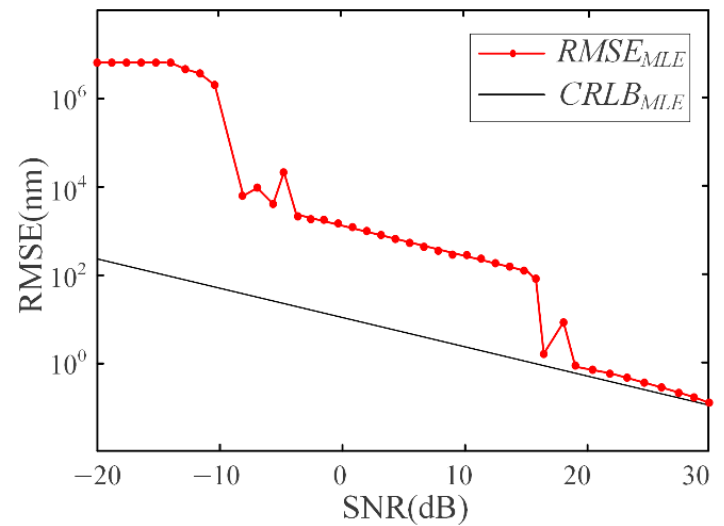
Figure 5. Root mean square error and Cramer–Rowe lower bound under different SNR.